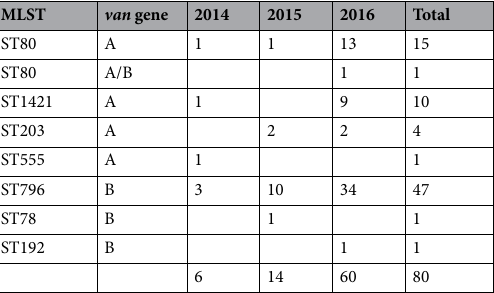
Table 1. Distribution of MLST sequence types and vancomycin-resistance loci identified for the Enterococcus faecium (VREfm) isolates from the Royal Hobart Hospital that were whole-genome sequenced ( n = 80).